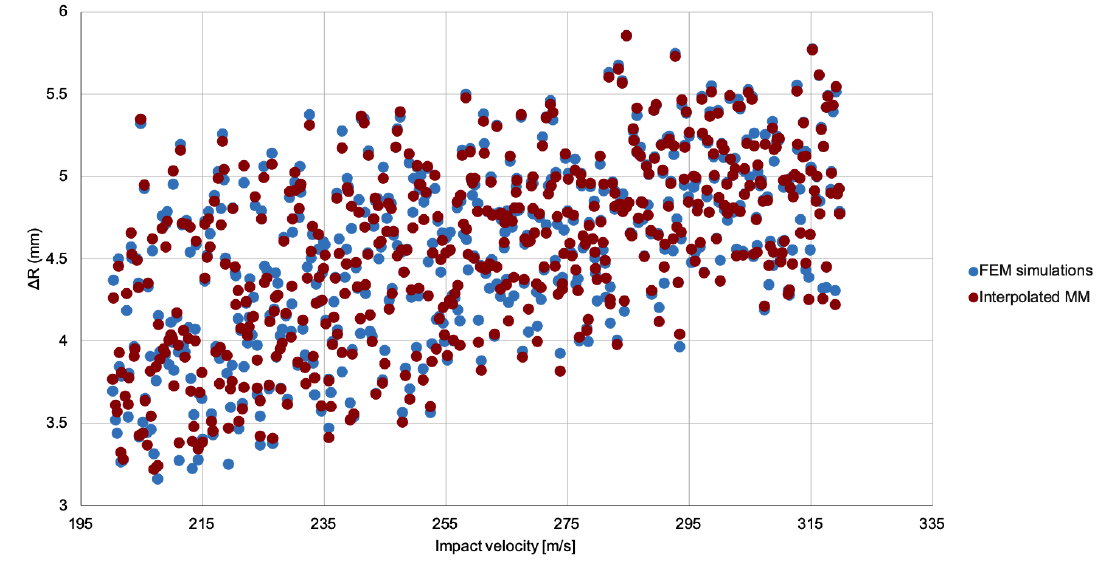
Figure 12. Comparison of meta-models interpolated results and FEM simulation results, considering ∆ R for the Arrhenius-type model.